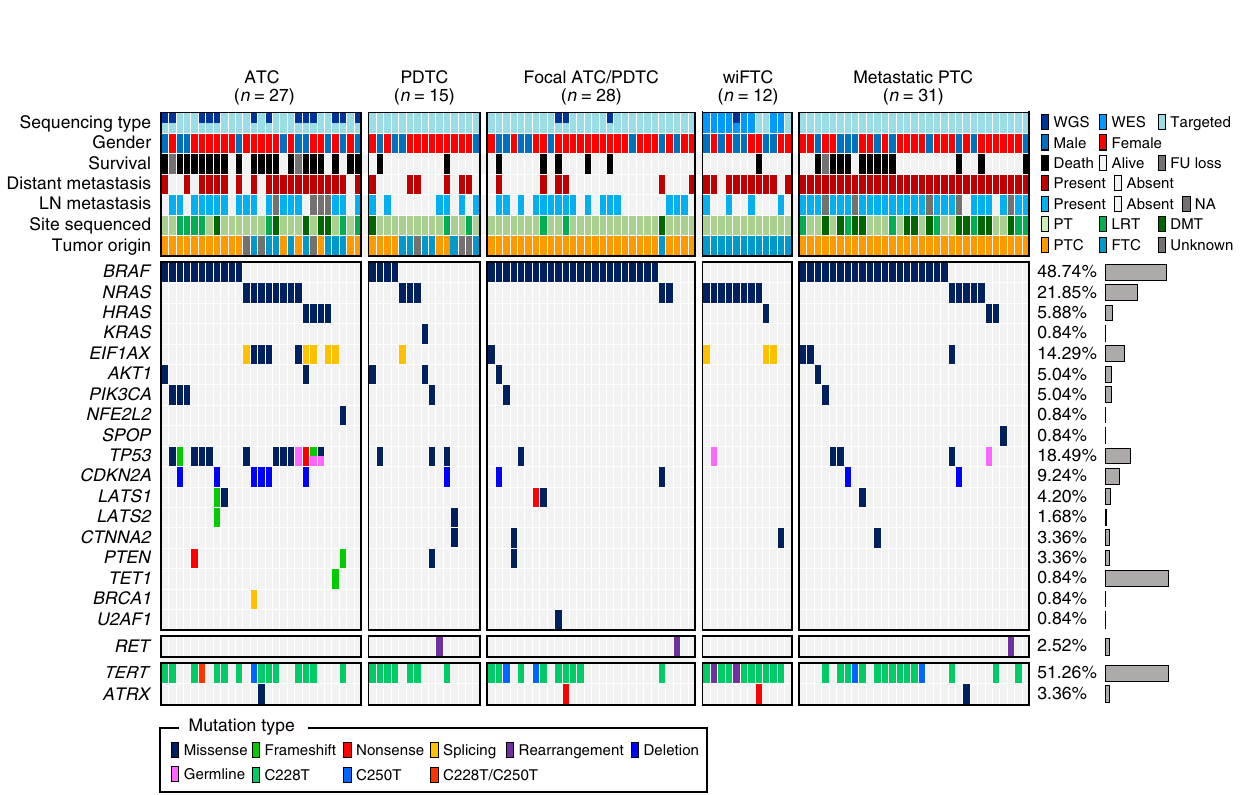
Fig. 1 The mutational landscape of ATC and advanced DTCs. Each column represents an individual tumor. Only genes harboring mutations con fi rmed to be somatic in at least one tumor were displayed. Genes were sorted by their functions as oncogenes, tumor suppressors, splicing machinery gene, RET fusion, and telomere lengthening genes. The right bar chart represents the frequencies of gene alterations across 113 advanced TCs. FU, LN, NA, PT, LRT, and DMT indicate follow-up, lymph node, not available, primary tumor, locally recurred or residual tumor, and distant metastatic tumor, (Supplementary Fig. 7). Additionally, the expression levels of TERT , induced by promoter mutations, were signi fi cantly higher in ATC than in DTC ( P = 0.006; Fig. 2h). This may be due to the expansion of sub-clones with TERT promoter mutations in ATC, as previously described 8 .